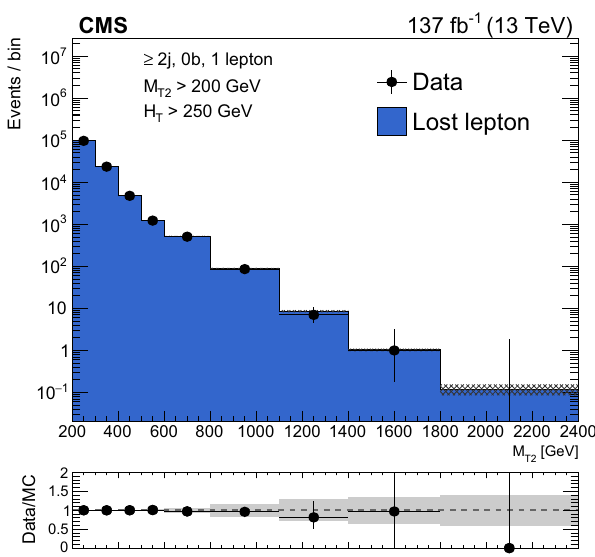
els show the MC statistical uncertainty, while the solid gray bands in the ratio plots show the systematic uncertainty in the M T2 shape. The bins have different widths, denoted by the horizontal bars